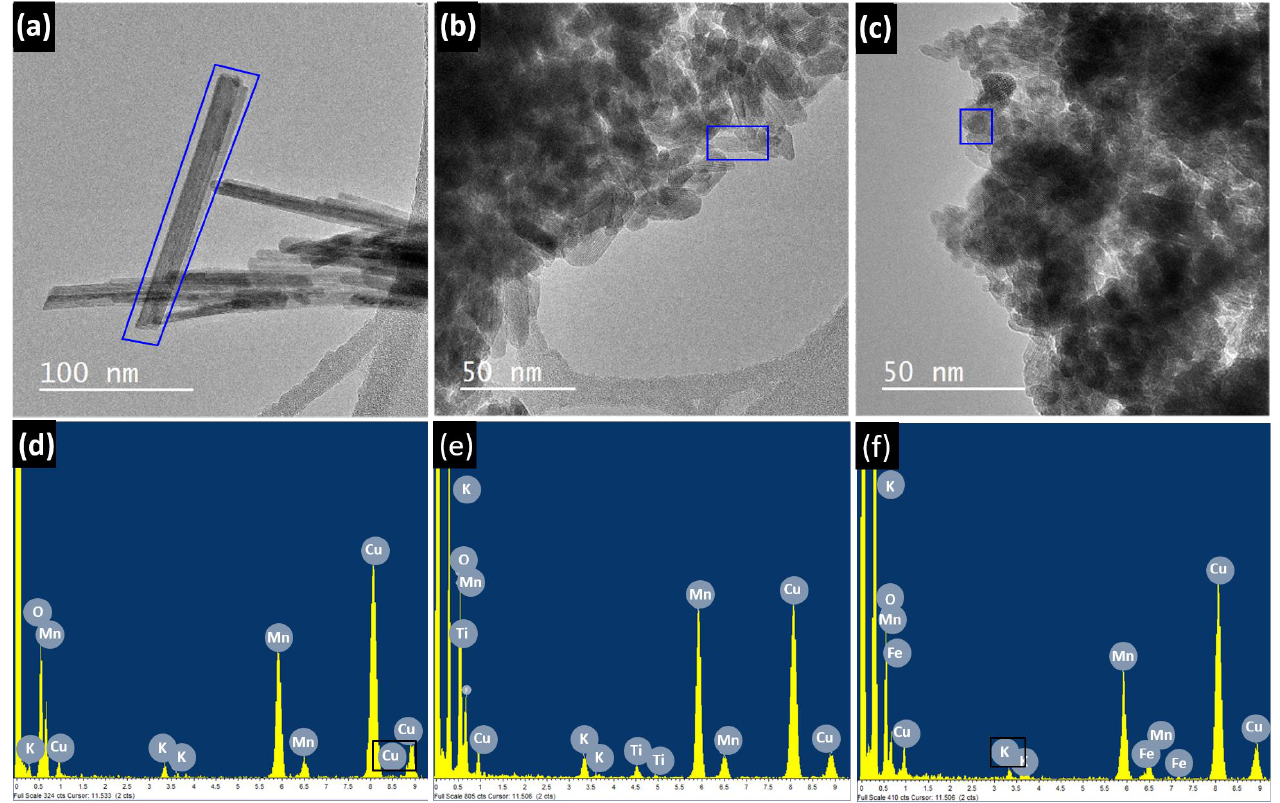
Figure 5. Low-magnification TEM images corresponding to the undoped sample ( a ); ( b ) the sample doped with 5% Ti; ( c ) the sample doped with 15% Fe; ( d – f ) corresponding EDS spectra.